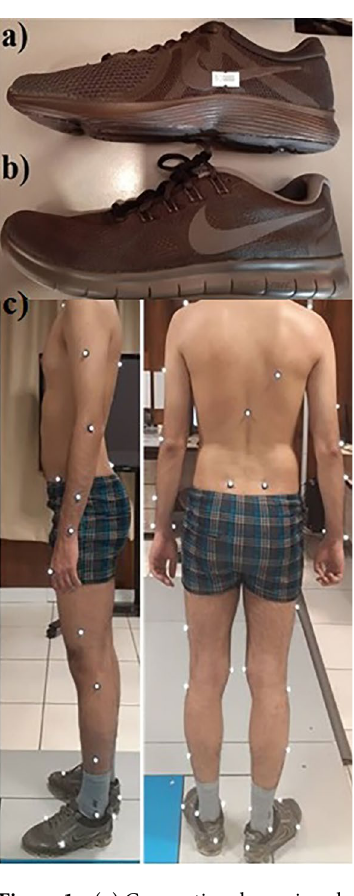
Figure 1. ( a ) Conventional running shoe, ( b ) auxetic Nike free RN shoe and ( c ) placement of Vicon markers in the sagittal and frontal planes.